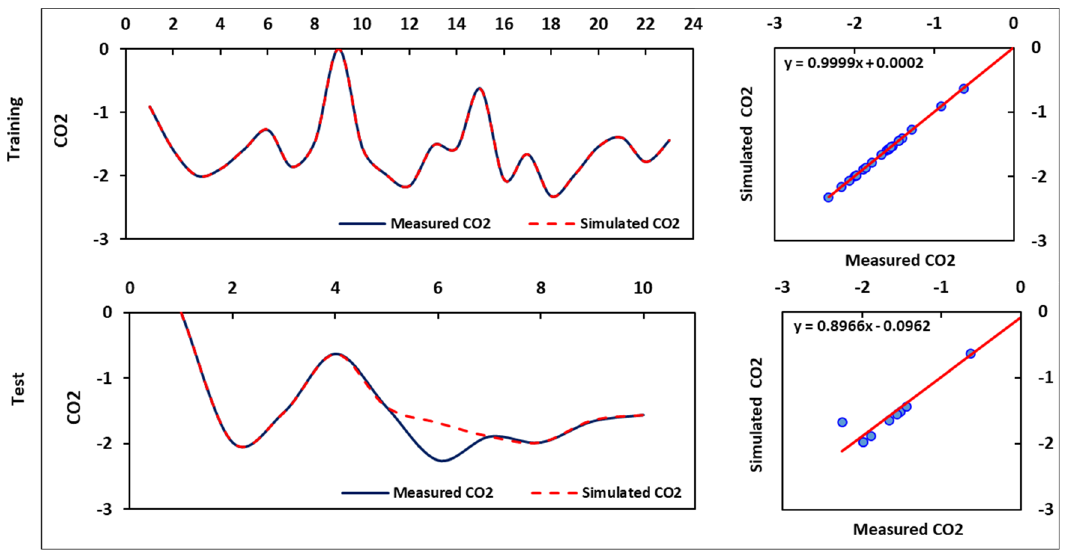
Figure 17. Results of the ANFIS model-based simulated CO 2.